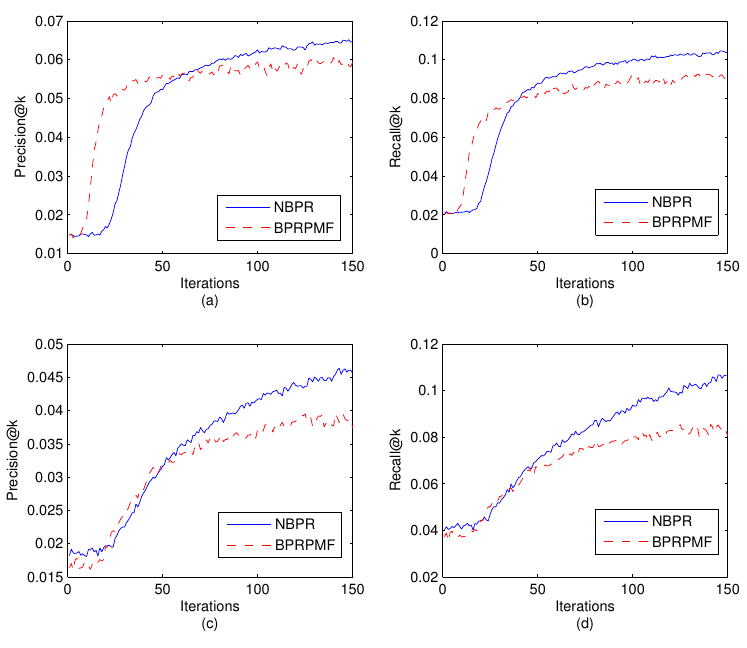
Figure 6. The convergence comparison results on two LBSNs. ( a ) Precision@ k in the Gowalla data; ( b ) Recall@ k in the Gowalla data; ( c ) Precision@ k in the Brightkite data; ( d ) Recall@ k in the Brightkite